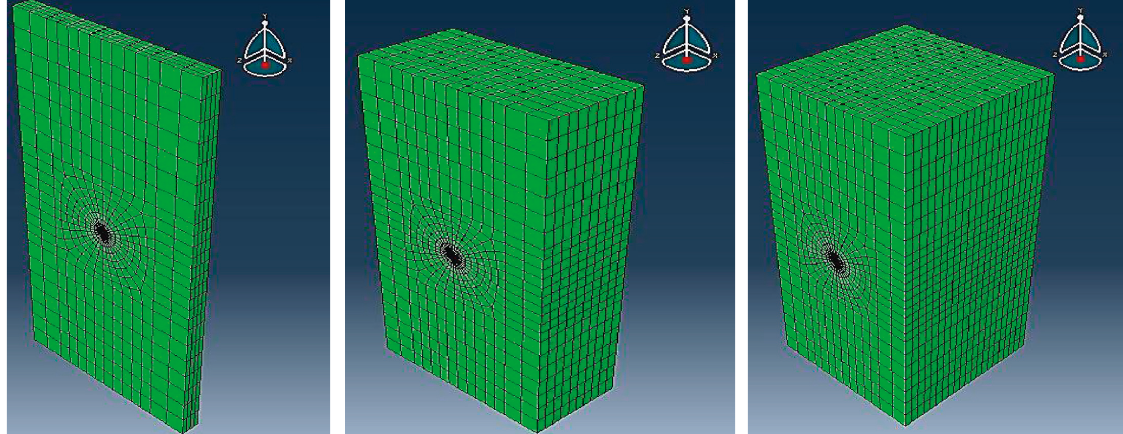
Figure 16: Meshing and modeling of object with different